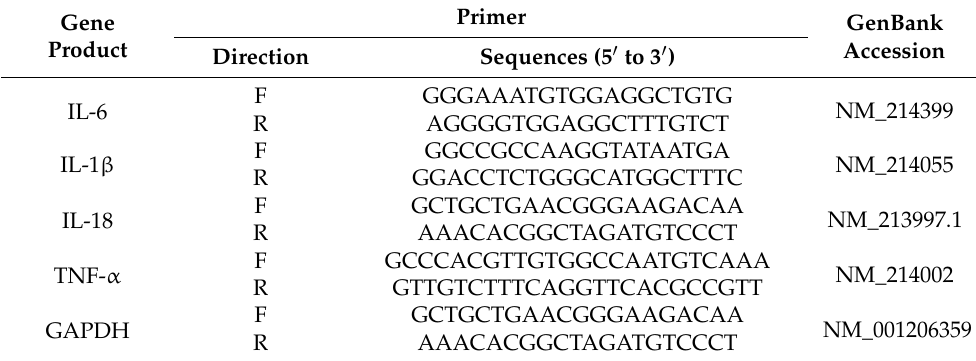
Table 1. Information of oligonucleotide primers used for real-time